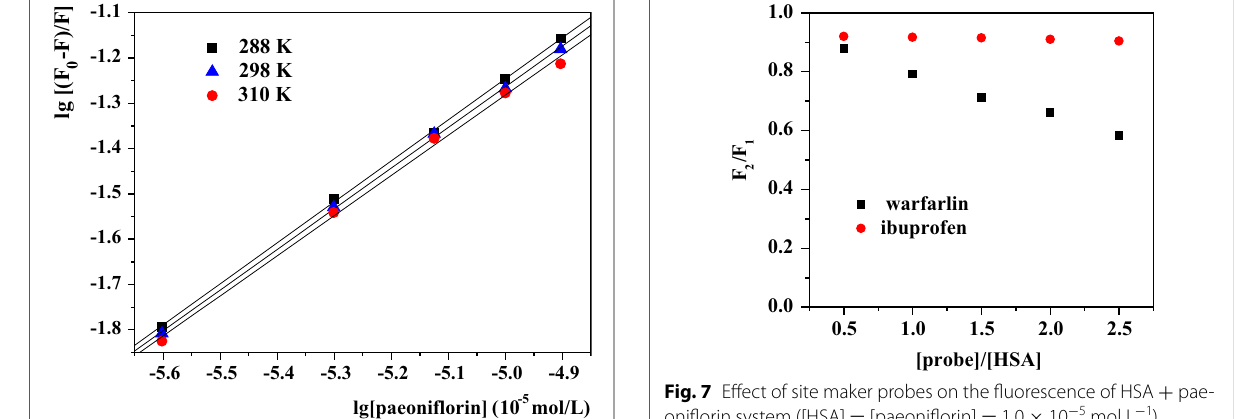
1.0 10 − 5 mol L − 1 ) = ×